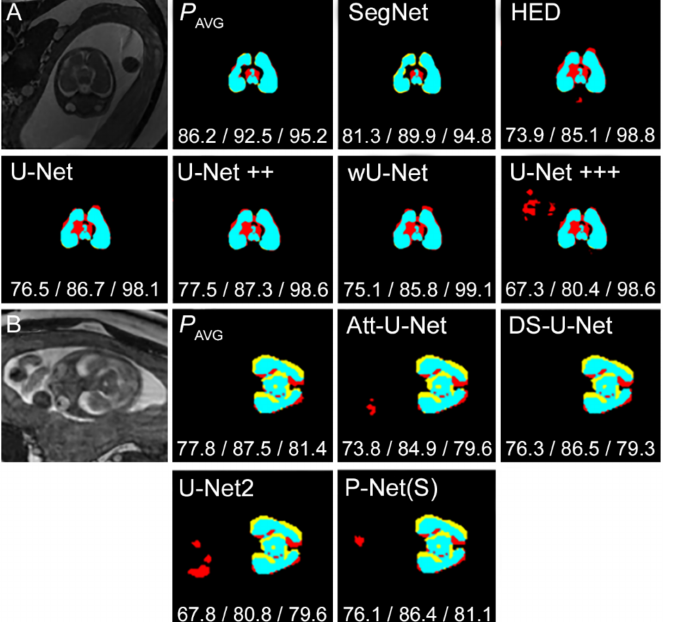
Figure 6. Two segmentation examples ( A , B ) providing a visual comparison between SIMOU-Net ( P AVG ) and ( A ) SegNet, HED, the original U-Net and its variants and ( B ) some of the latest networks, Att-U-Net, DS-U-Net, U-Net2 and P-Net(S). Black, cyan, red and yellow represent TN , TP , FP and FN , respectively. Jaccard/Dice/Sensitivity scores are shown under each